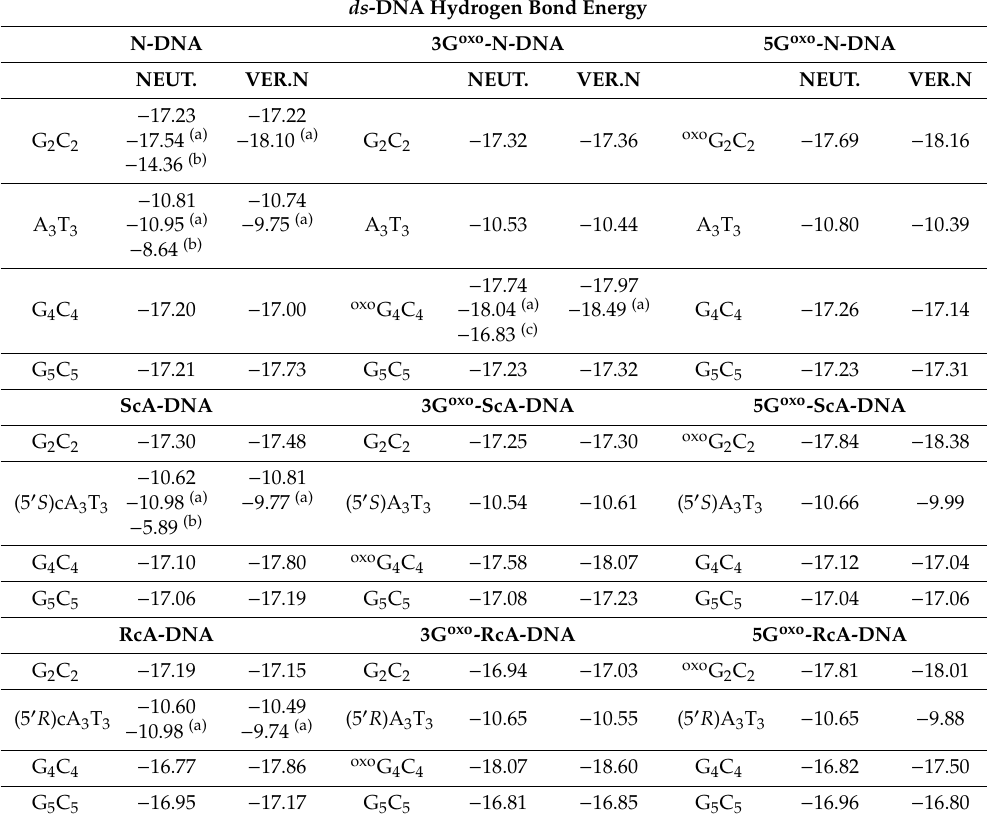
Table 5. Hydrogen bond energy in kcal / mol of base pairs included in the structure of the discussed ds -oligonucleotides in their neutral (Neut.) and vertical neutral (after electron adoption by adiabatic radical cation) (VER.N) form: (a) calculated for an ideal base pair model, (b) calculated for base pairs extracted / selected from 2lsf.pdb [45] and (c) 5iv1.pdb [46]